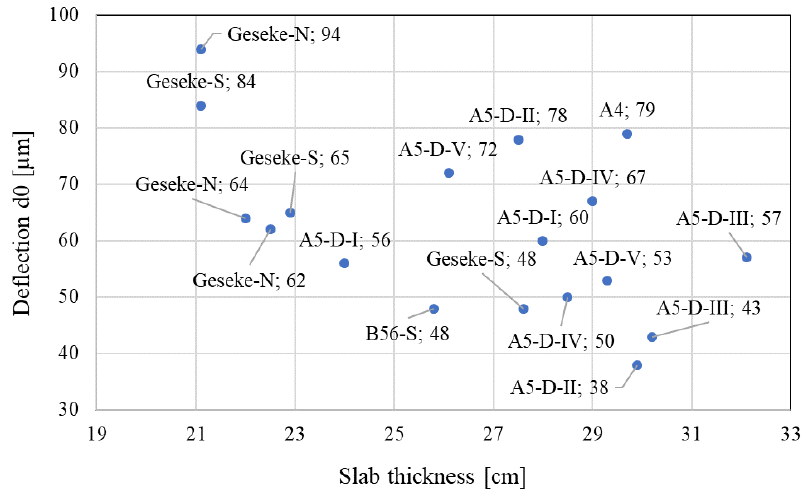
Figure 13. Average deflection in CRCP sections with different slab thickness.